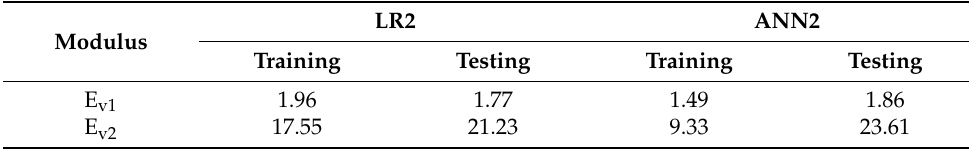
Table 5. RMSE results for ANN2 and